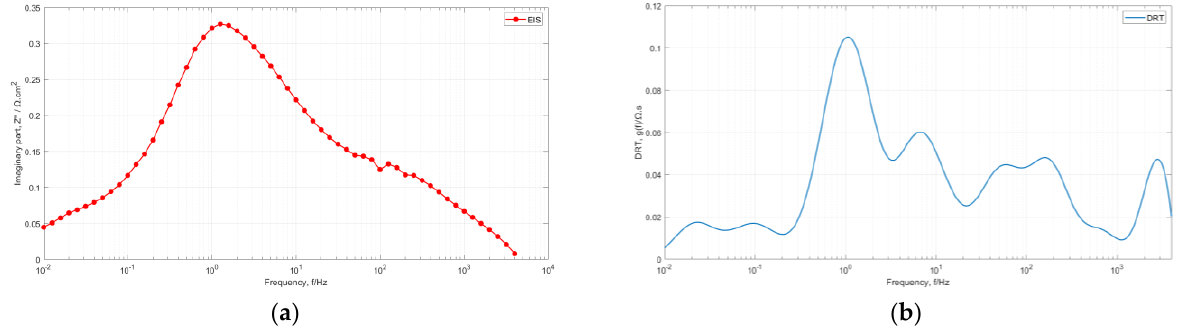
Figure 1. Comparison of the ( a ) EIS measurement and ( b ) its DRT deconvolution of one of the samples analyzed in this study.